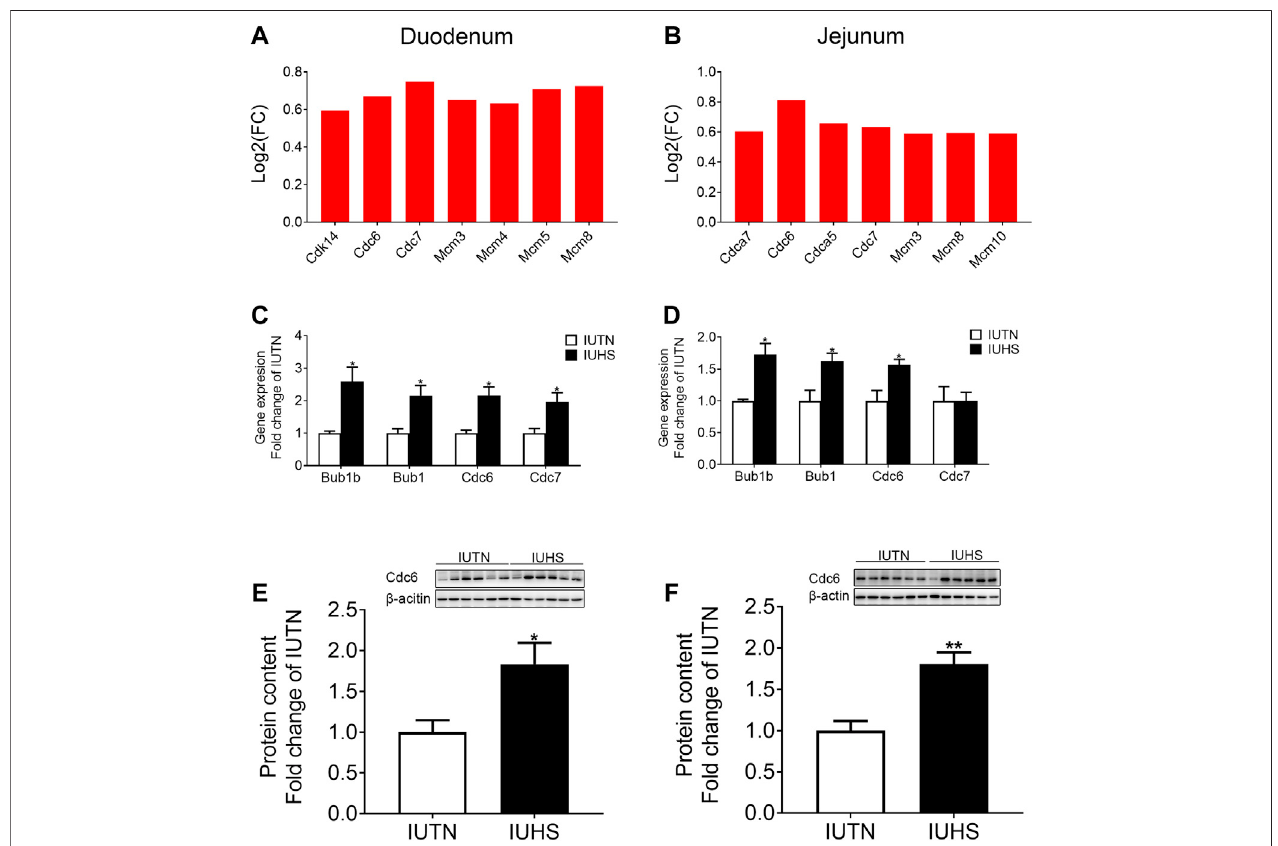
FIGURE5| Effects ofHSduringlategestationonthecell cycleoffetalduodenumandjejunum.FoldchangeofDEGs (A) ,mRNAexpression (C) ,and protein levels (IUTN: n =8;IUHS: n =5) (E) in thefetalduodenum.FoldchangeofDEGs (B) ,mRNAexpression (D) ,and protein levels (IUTN: n =8;IUHS: n =5) (F) inthefetal jejunum. Gene symbols are shown on the x-axis, and log 2 FC is shown on the y-axis. Red bars: up-regulation. Data are presented as mean ± SEM. * p < 0.05, ** p < 0.01.